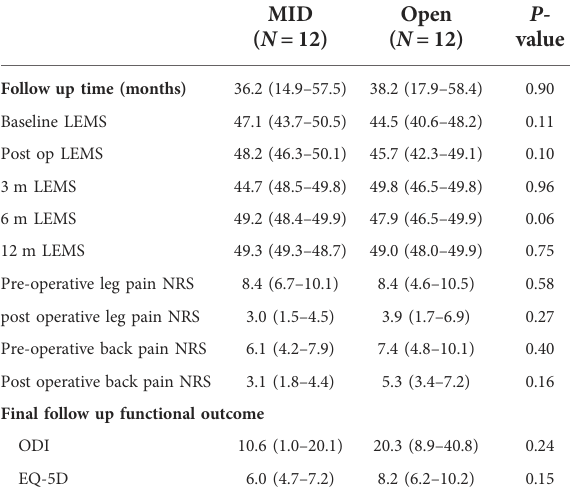
TABLE 5 Postoperative neurological and functional